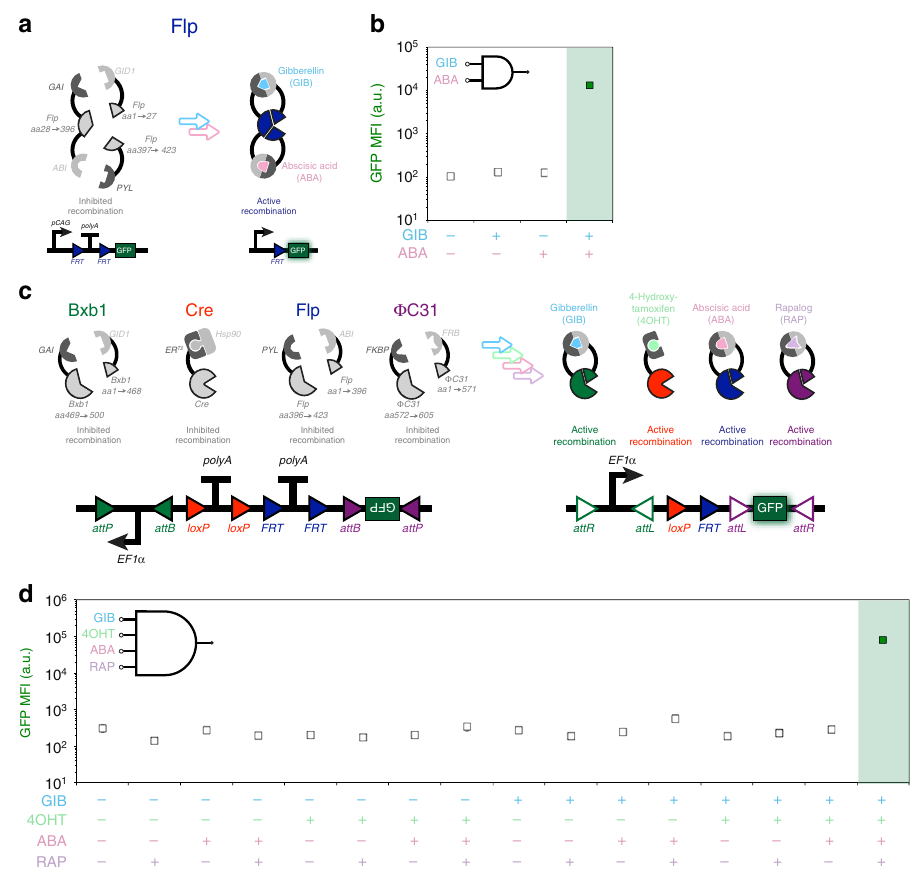
Fig. 4 Protein and DNA-based recombinase logic gates. a A two-input protein-based AND gate is created by splitting Flp recombinase at two locations ( S 1 = 27, S 2 = 396) and fusing to the gibberellin (GIB)- and abscisic acid (ABA)-associated chemical inducible dimerization domains. b Plotted results indicate GFP mean fl uorescence intensity (MFI) of four conditions of GIB and ABA. c Four chemical-inducible recombinases can be used together to generate a DNA-based 4-input logic gate; these include a gibberellin-inducible split Bxb1 ( S = 468), 4-hydroxytamoxifen (4OHT)-inducible ER T2 -Cre-ER T2 , abscisic acid (ABA)-inducible split Flp ( S = 396), and rapalog (RAP)-inducible split ɸ C31 ( S = 571). Drugs were added 2 h post transfection. d Plotted results indicate GFP. MFI of 16 conditions of GIB, 4OHT, ABA, and RAP. Error bars of MFI indicate the arithmetic standard error of the mean between three transfected cell cultures. Source data are provided as a Source Data fi